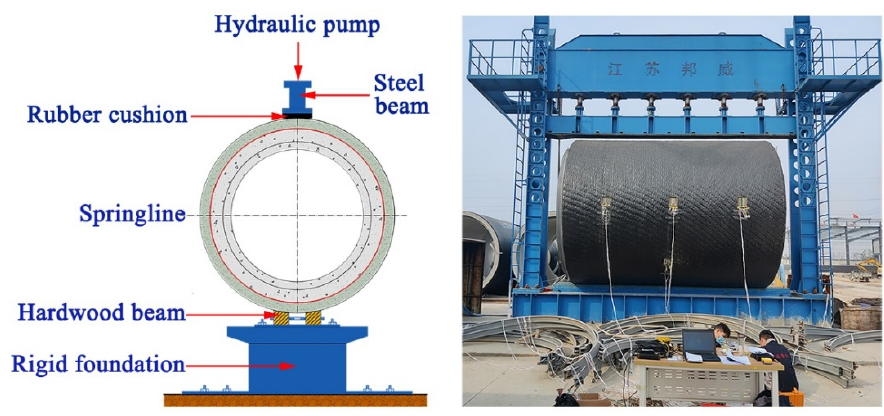
Figure 7. Schematic diagram of the load device.